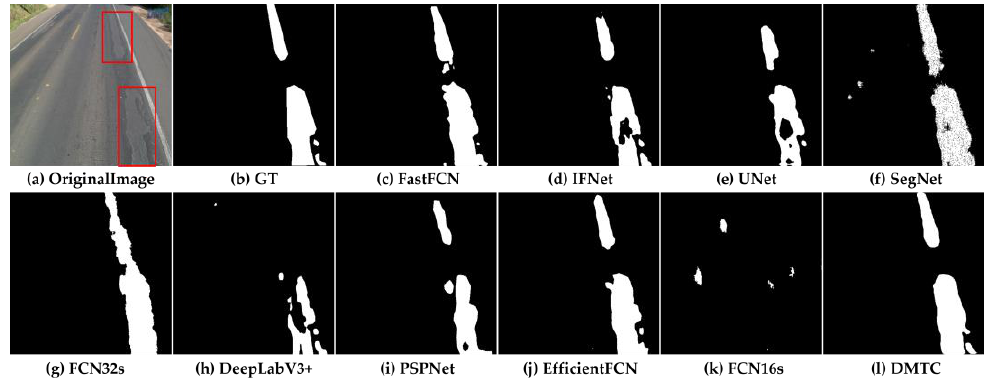
Figure 10. Visual comparison of the results of a series of segmentation methods for large potholes on